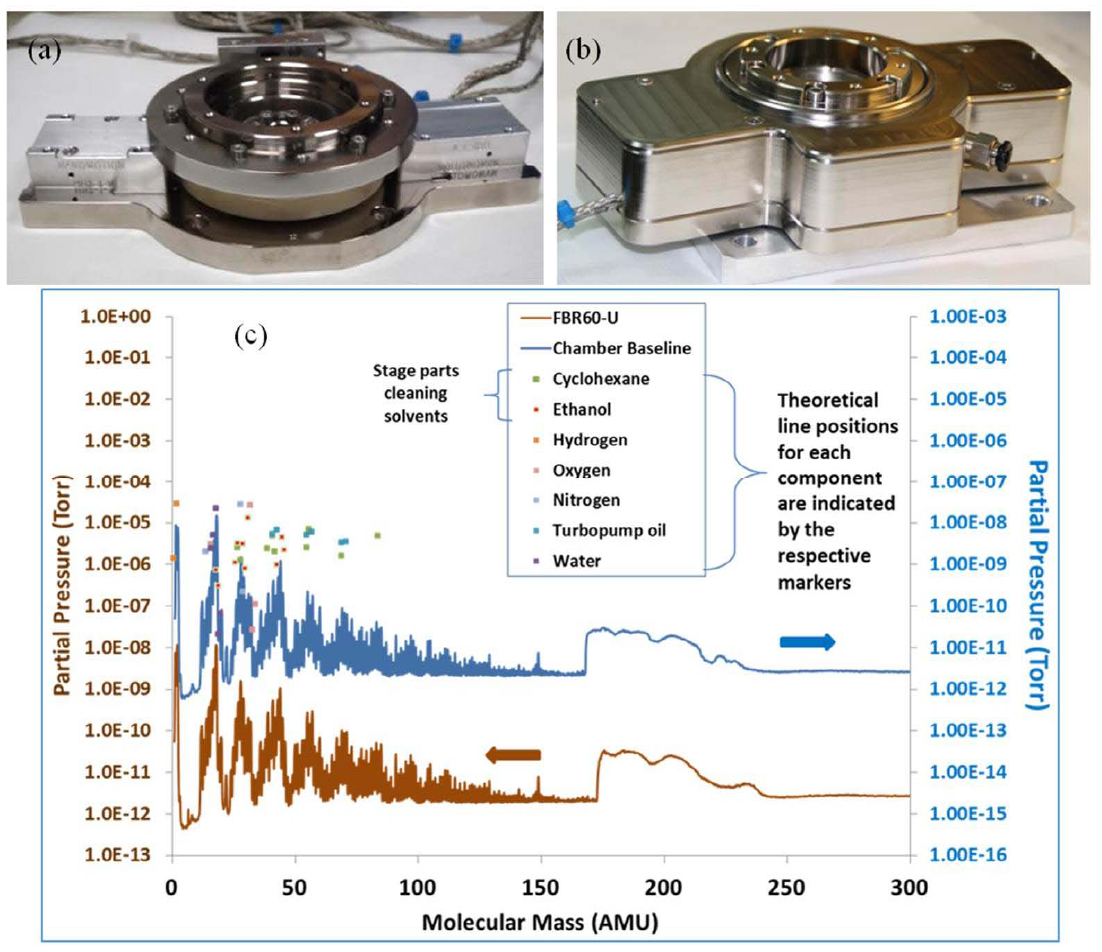
Figure 12. Nanomotion FBR60-U rotary stage based on two HR2 vacuum motors: ( a ) Image of the stage without the encapsulating case. ( b ) Image of the stage with the encapsulating case. ( c ) Residual gas analysis analog scan of an FBR60-U high vacuum rotary stage idle in active vacuum (30 L vacuum